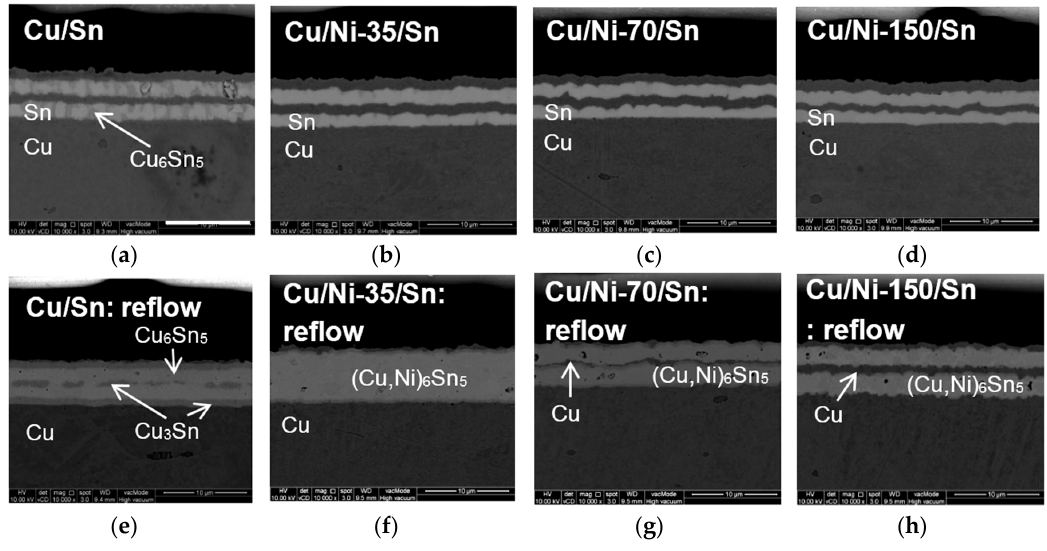
Figure 3. FESEM micrographs showing cross sectional images of ( a , e ) Cu/Sn; ( b , f ) Cu/Ni-35/Ni; ( c , g ) Cu/Ni-70/Ni; and ( d , h ) Cu/Ni-150/Ni before and after reflow at 250 °C for 60 s, respectively, at a magnification of 10,000×.